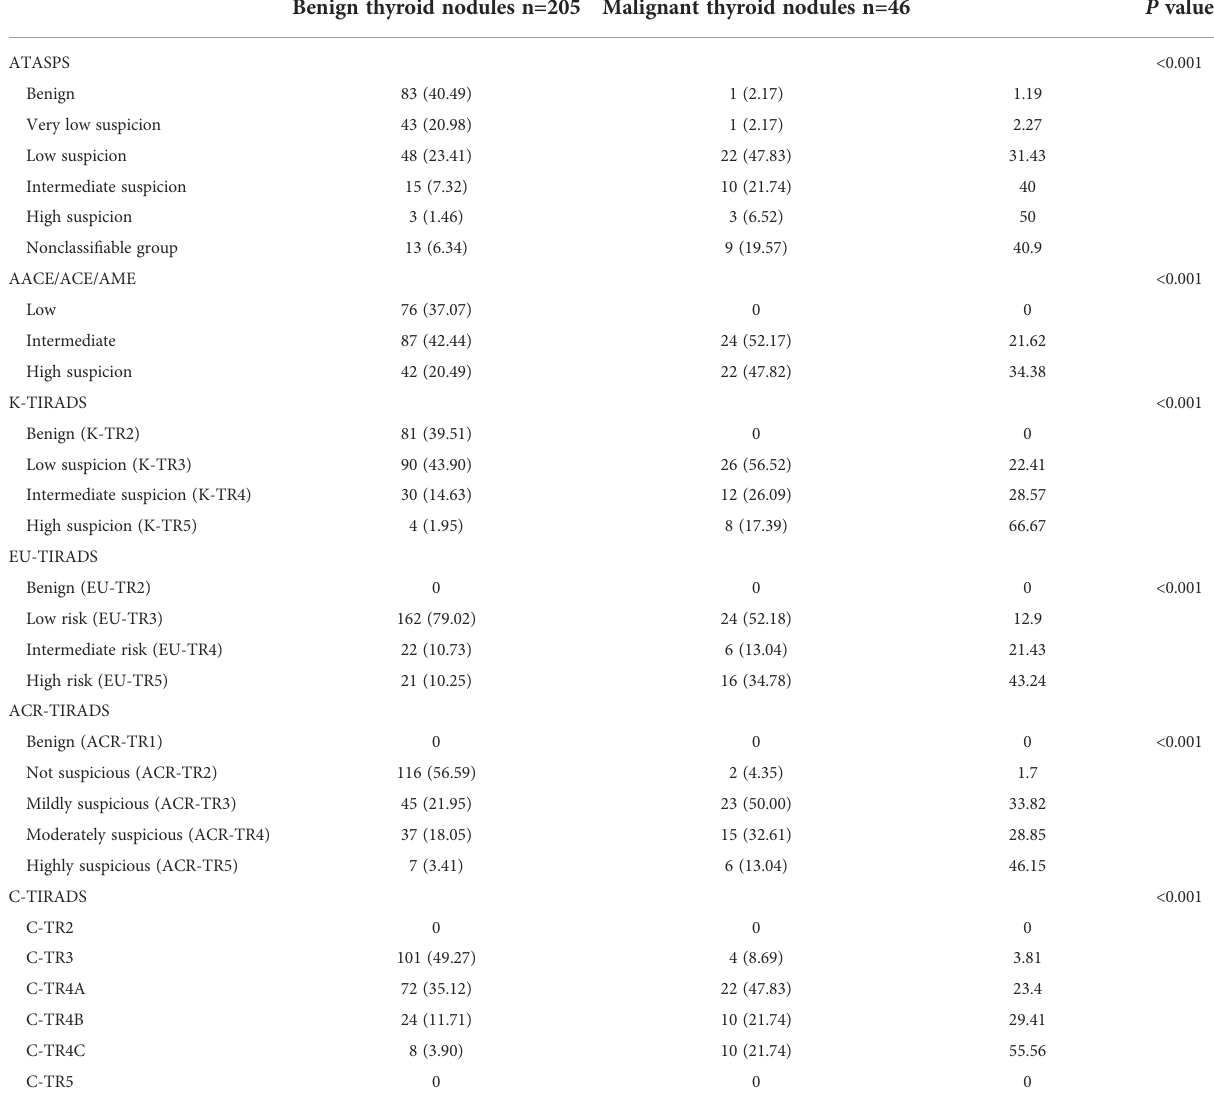
TABLE 3 Malignancy rate of thyroid nodules assessed by the six ultrasound-based risk strati fi cation systems.